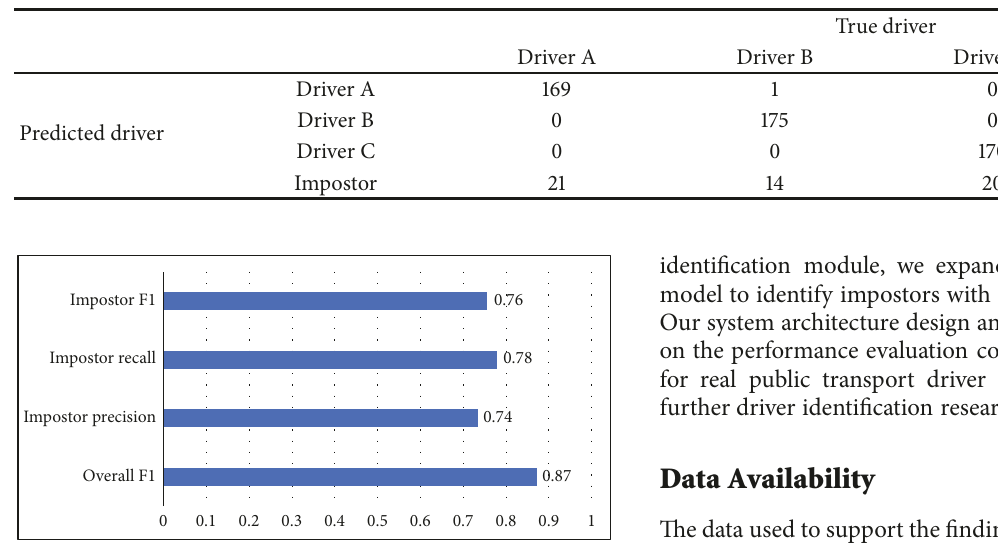
Figure 18: Plot of overall F1, impostor precision, impostor recall, and impostor F1 when utilizing the k-nearest